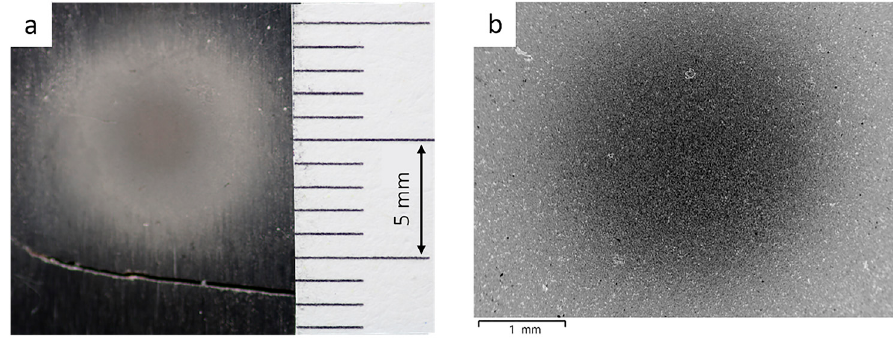
Figure 10. Images of the top surface after erosion: ( a ) digital image; ( b ) BSE-SEM image.